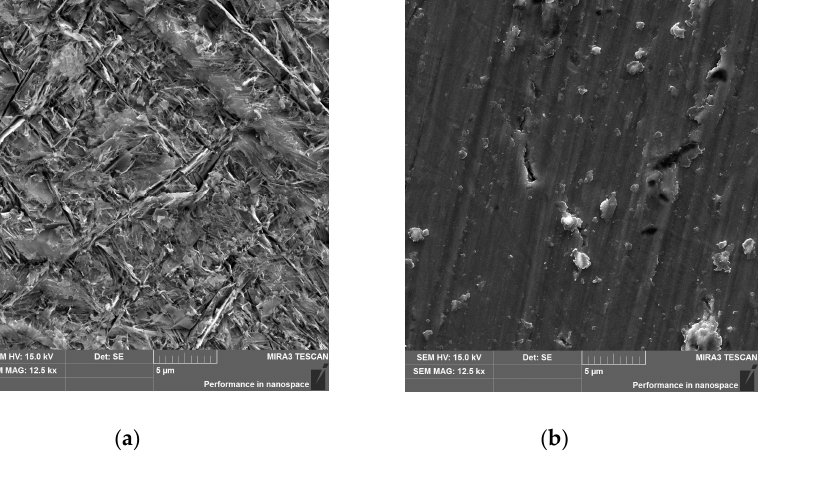
Figure 3. SEM image of the microstructure of the Ti-13Zr-13Nb alloy before and after anodizing in 1 M C 2 H 6 O 2 + 4 wt% NH 4 F electrolyte: ( a ) Etched; ( b ) Anodized at 5 V for 120 min; ( c ) Anodized at 10 V for 120